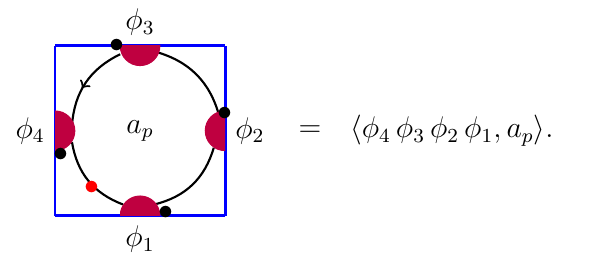
Figure 12 . We keep contracting tensors of rank 2 and trace the final contraction to obtain the virtual loop and the associated number.